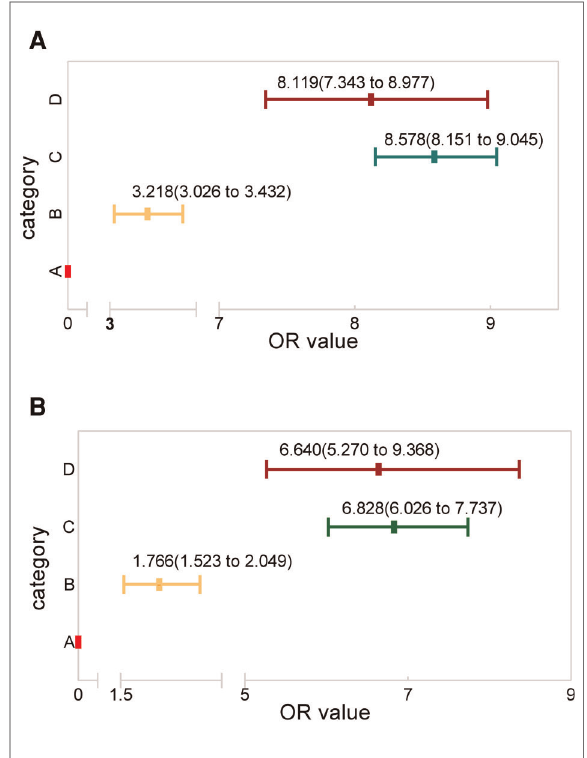
FIGURE 7 The OR value distribution among the four categories, with category A as reference for the ( A ) research and ( B ) validation